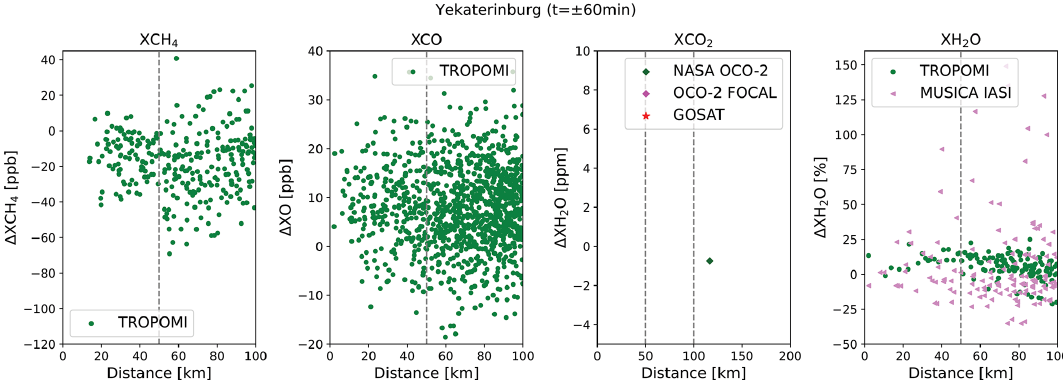
Figure A4. Same as Fig. A3 but for